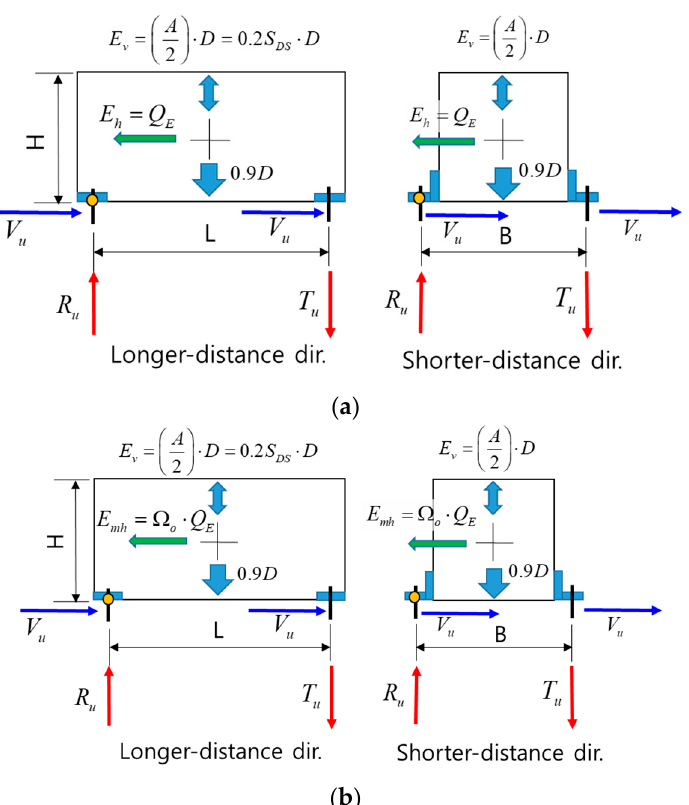
Figure 3. Load combinations when the primary load is an earthquake. ( a ) Redundancy factor. ( b ) Overstrength factor.